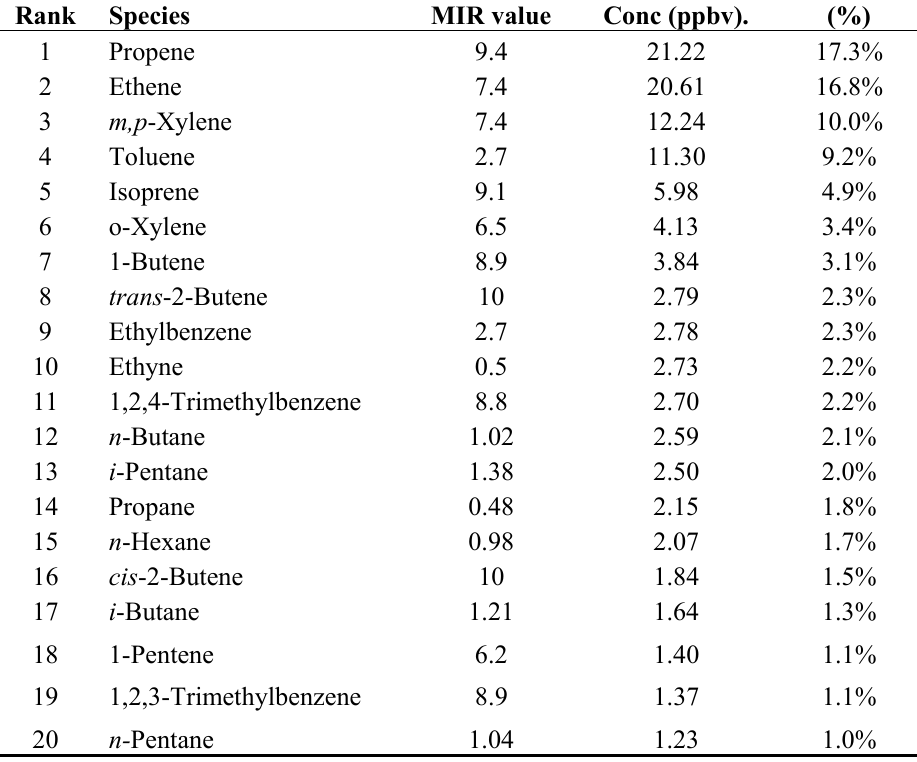
Note: MIR values are taken from Carter